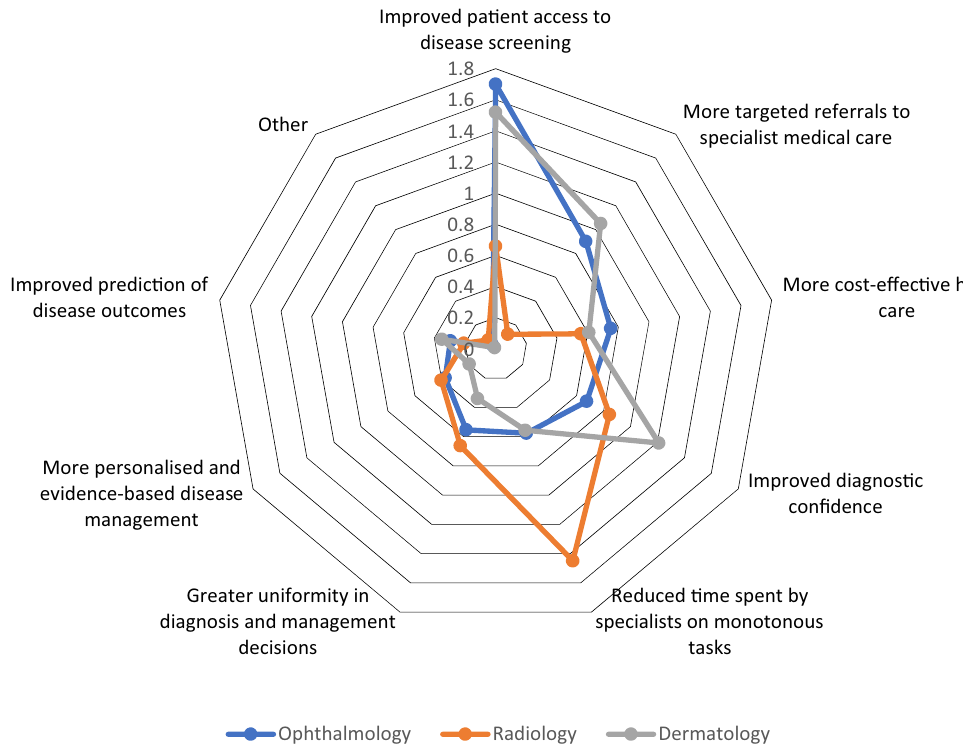
Figure 7. Radar plot showing the highest scoring responses for the greatest perceived advantages of the use of artificial intelligence. Responses were selected from a list of set choices. Plot axes represent the average ranks for all respondents, with higher scores indicating a higher ranking/stronger